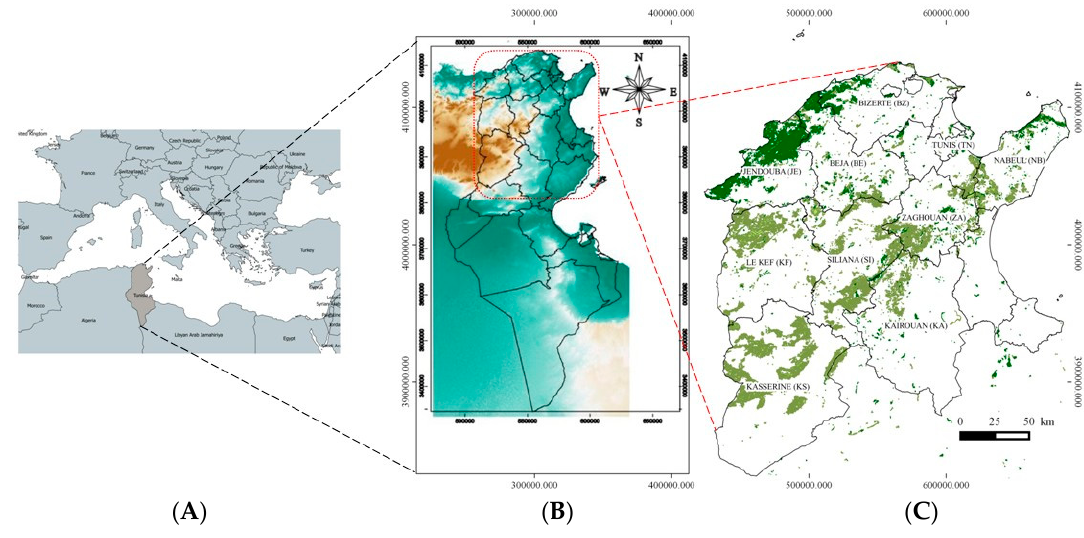
Figure 1. Location of Tunisia within the Mediterranean basin ( A ); with the map of altitudes ( B ); and administrative units ( Gouvernorat ) overlayed with forests/shrubland distribution ( C ).